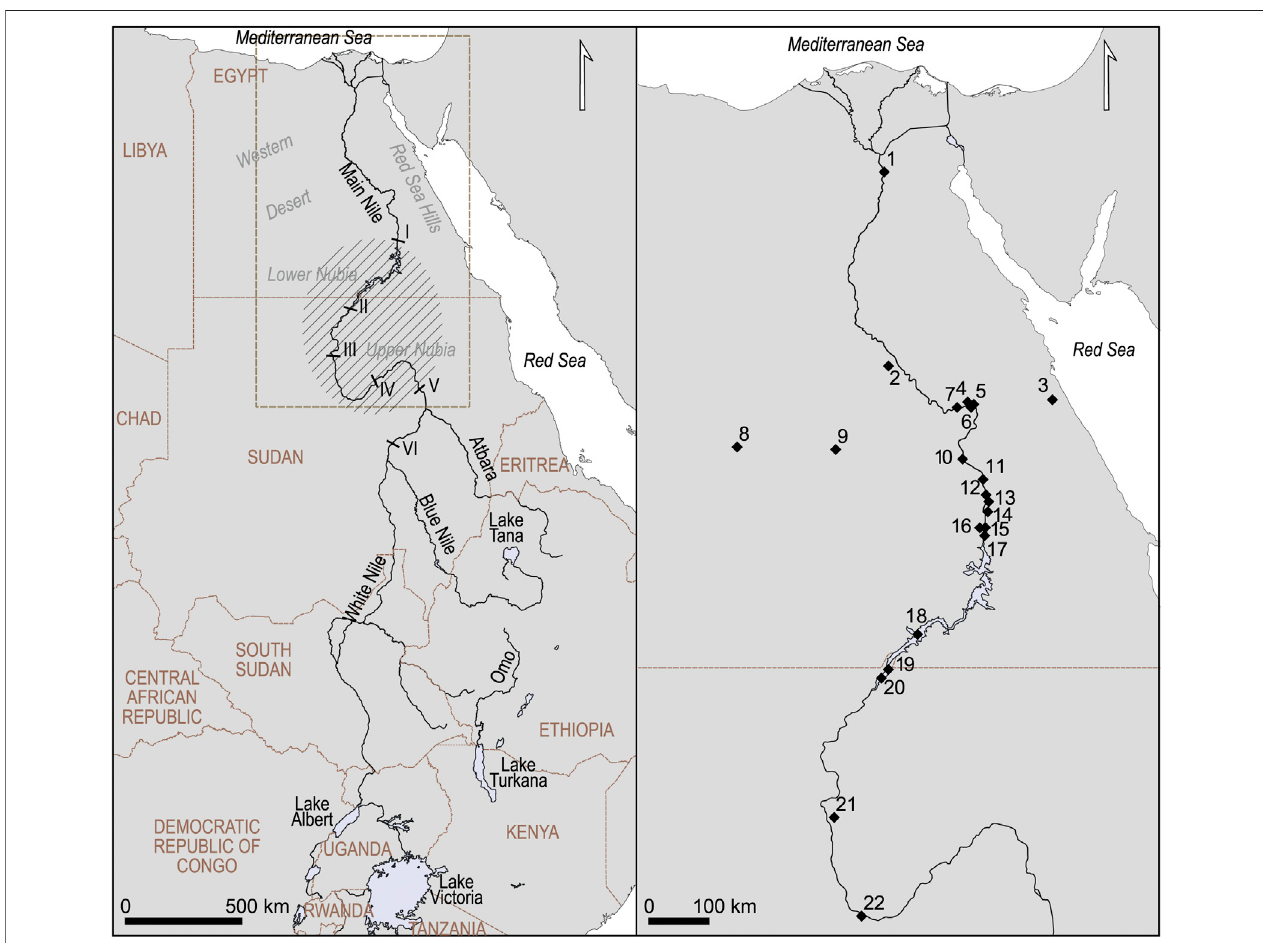
FIGURE 1 | Map of the Nile Basin (left) and the Main Nile Basin (right) . Created in QGIS v. 3.15 (QGIS Development Team, 2017) using Natural Earth Data. Hatchedarea:broadgeographicalextentofNubia.Numbers:geographicallocationsdiscussedinthetext;1,Helwan;2,NazletKhater;3,SodmeinCave;4,Makhadma; 5, Qena; 6, Taramsa; 7, Dishna; 8, Dakhleh Oasis; 9, Kharga Oasis; 10, Esna; 11, Edfu; 12, El Hosh; 13, Qurta; 14, Kom Ombo; 15, Wadi Abu Subeira; 16, Wadi Kubbaniya; 17, Aswan; 18, Tushka; 19, Jebel Sahaba; 20, Wadi Halfa; 21, El Barga; 22, Ed-Debba.